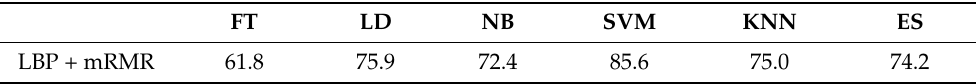
Figure 8. LBP—mRMR Flowchart. Table 4. Accuracy rate of LBP + mRMR